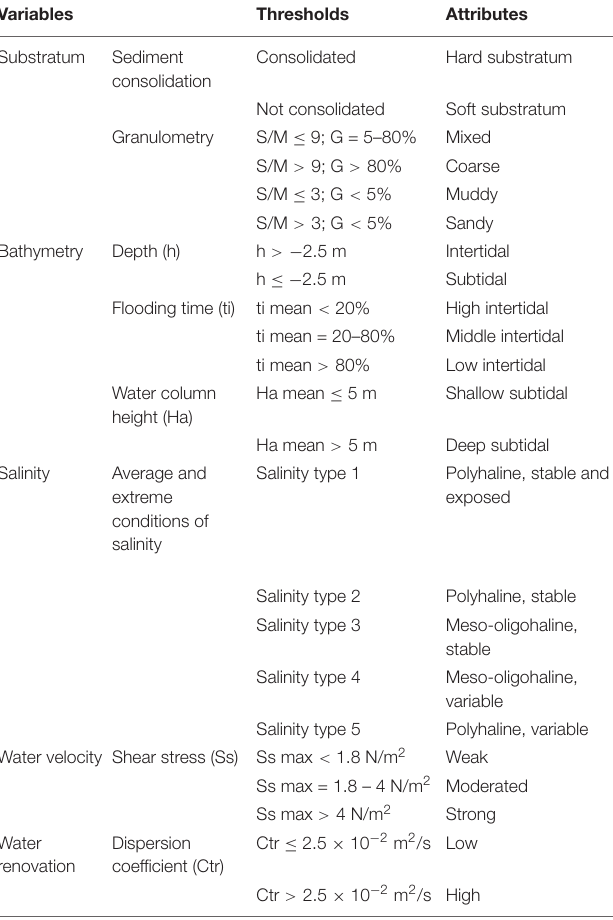
TABLE 1 | Variables and classes (thresholds and attributes) included in the classification system of the estuarine physiotopes.